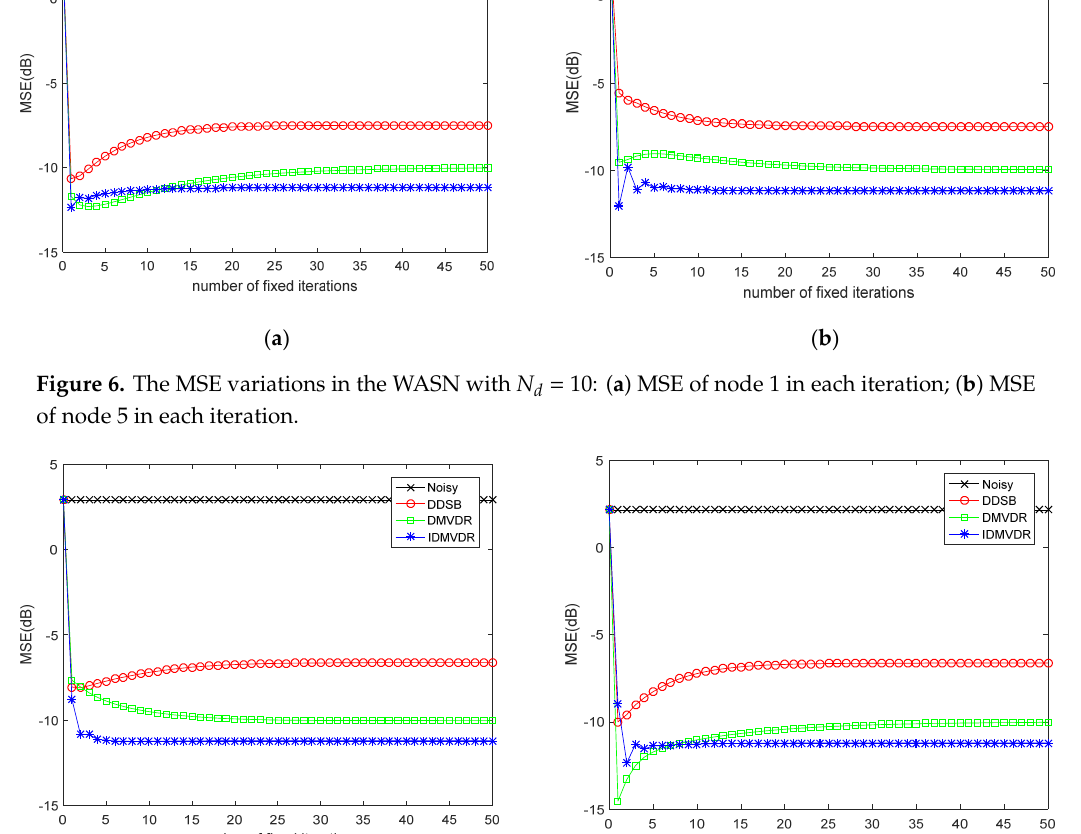
Figure 7. The MSE variations in the WASN with N d = 15: ( a ) MSE of node 8 in each iteration; ( b ) MSE of node 5 in each iteration.